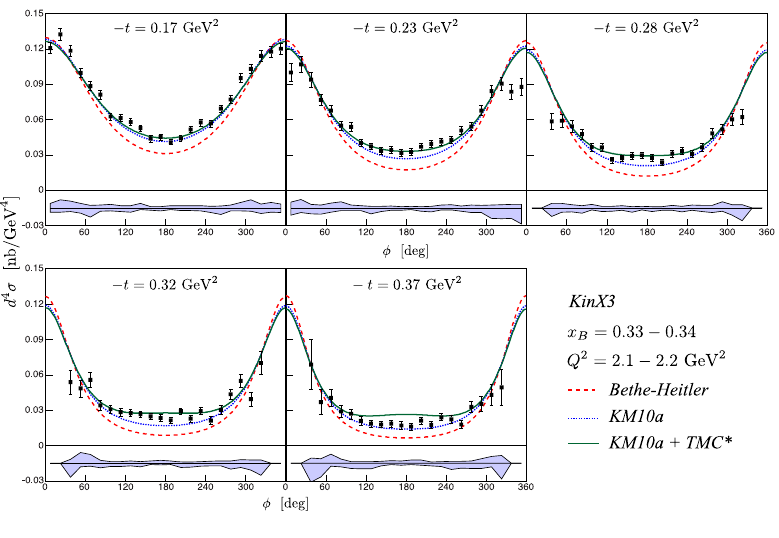
Figure 6. The (unpolarized) DVCS cross section as a function of the azimuthal angle φ [56] compared to the GK12 GPD model